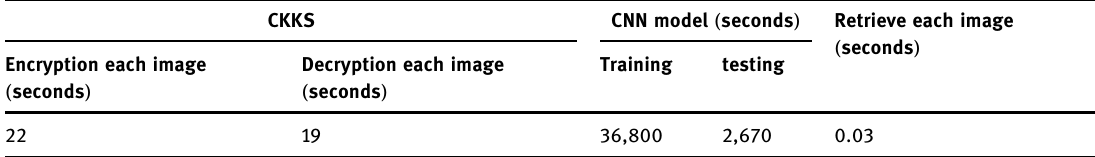
Table 10: Time results